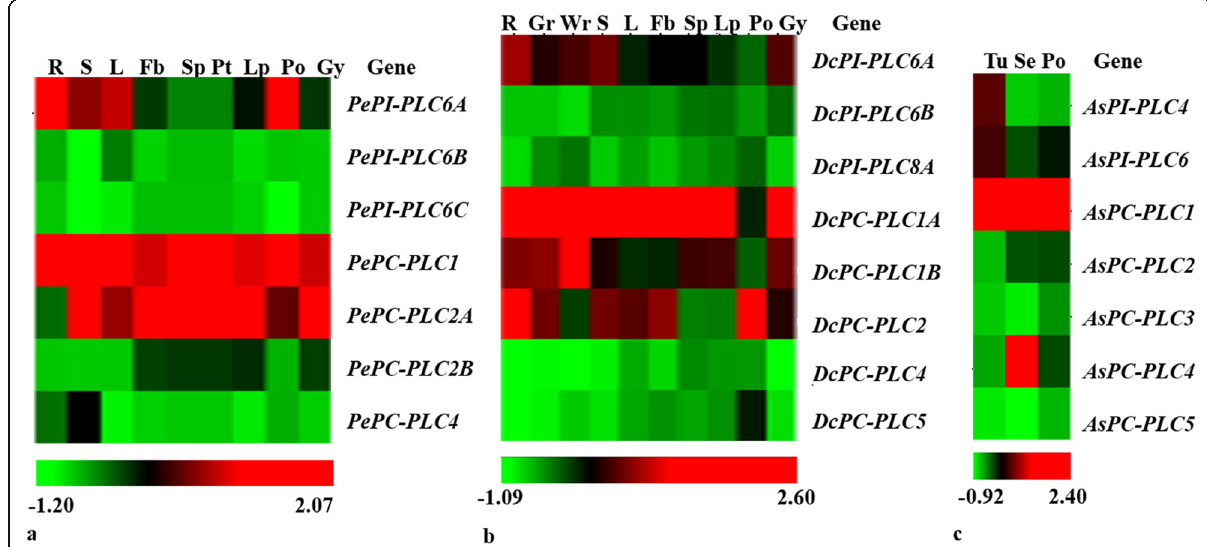
Fig. 6 Expression profiling. The expression profile in the form of a heat map for ( a ) PePLC ( b ) DcPLC , and ( c ) AsPLC in different tissues such as leaf (L), root (R), green root tip (Gr), white part of the root (Wr), stem (S), flower bud (Fb), sepal (Sp), petal (Pt), labellum (Lp), pollinia (Po), and gynostemium (Gy), Tuber (Tu), and seed (Se) was generated by using HCE3.5